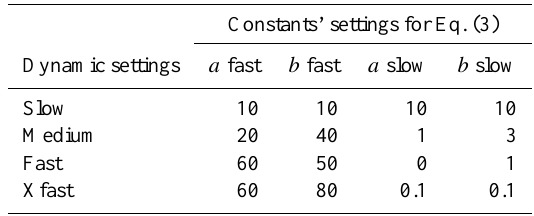
Table 3. Selected settings for permafrost decomposition function, where subscript indicates the soil pool. Permafrost area model is LOW-MEDIUM for